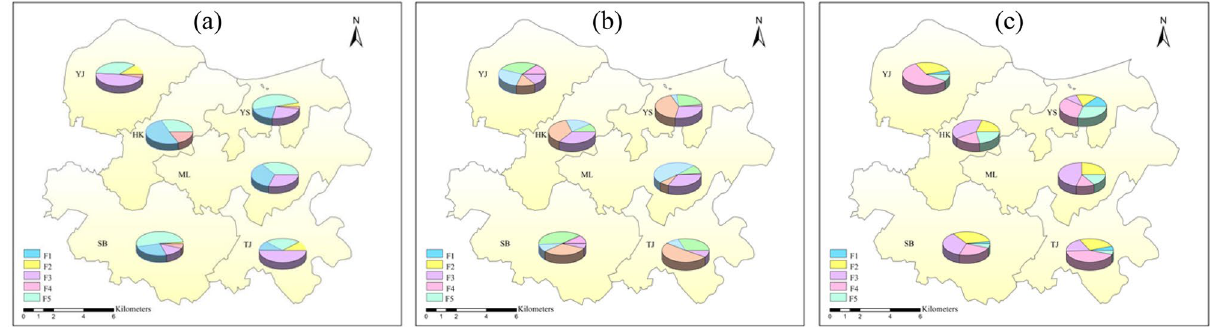
Figure 7. The distribution characteristics of Cd source contribution ratios in different towns, ( a ) soil cadmium; ( b ) activated cadmium; ( c ) rice